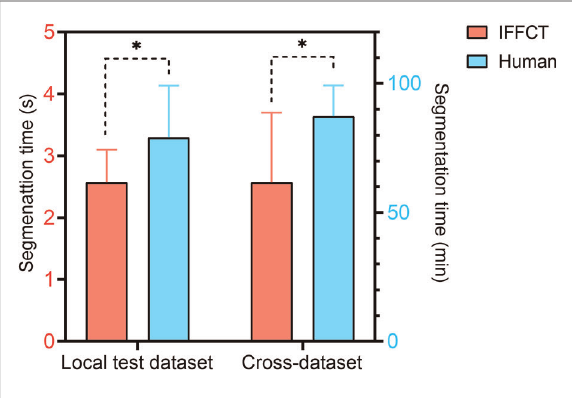
FIGURE 9 Segmentation time of human experts and IFFCT in local test dataset and cross-dataset. Local test dataset: 2.6±0.5s vs 79.1±20.1 min; cross-dataset, 2.6±1.1s vs 87.4±11.9 min. * P <0.01.